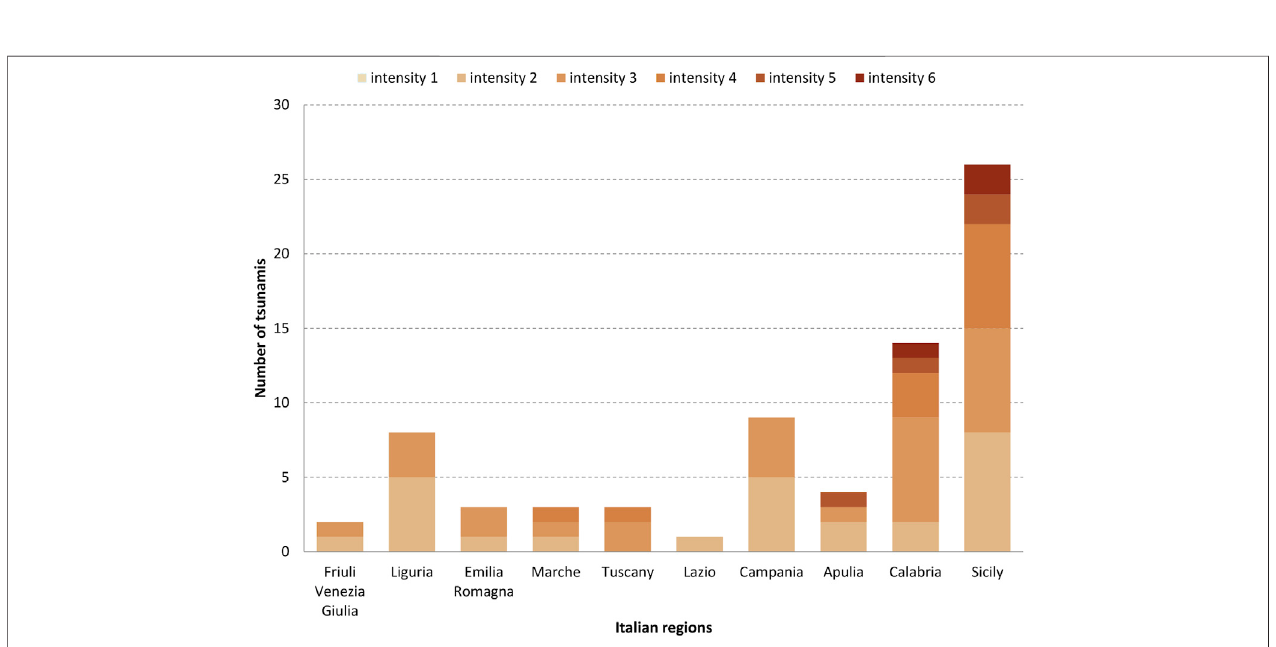
FIGURE 7 | Regional distribution of Italian tsunamis per intensity classes.